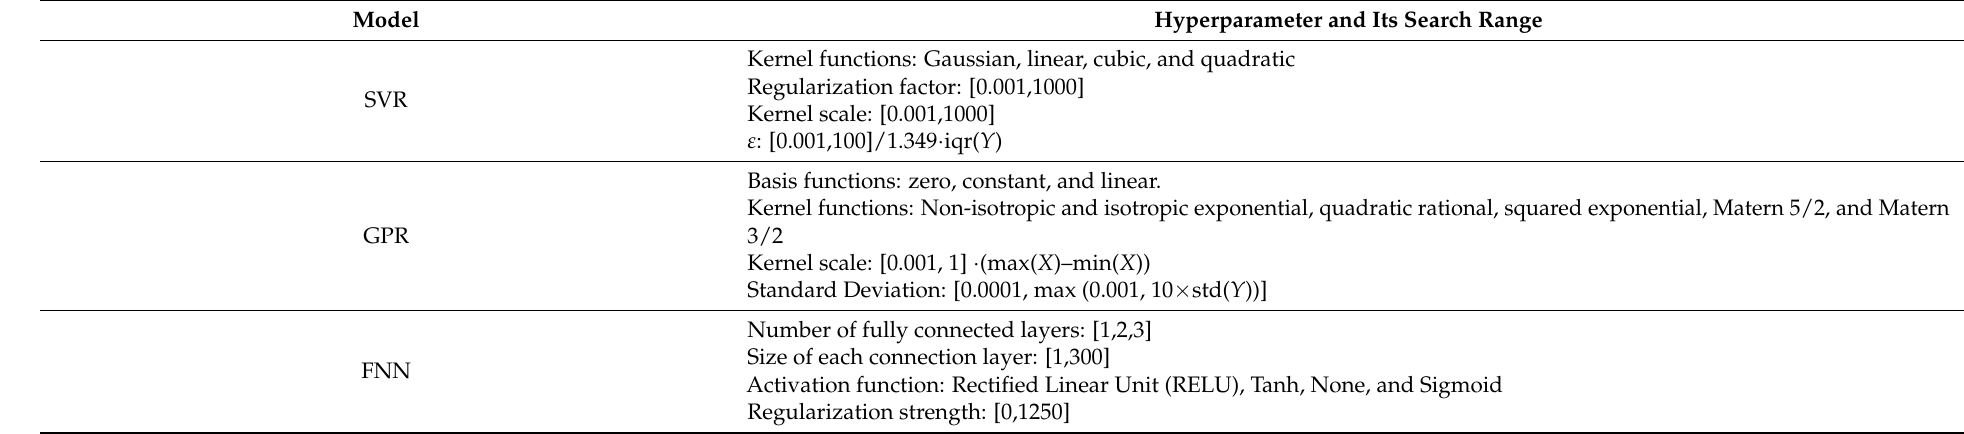
Table 1. Hyperparameter and its search range in each ML